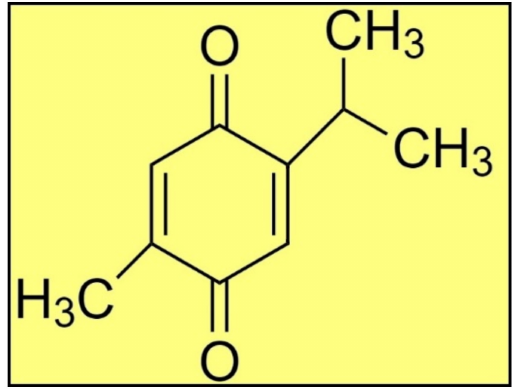
Figure 1. The structure of